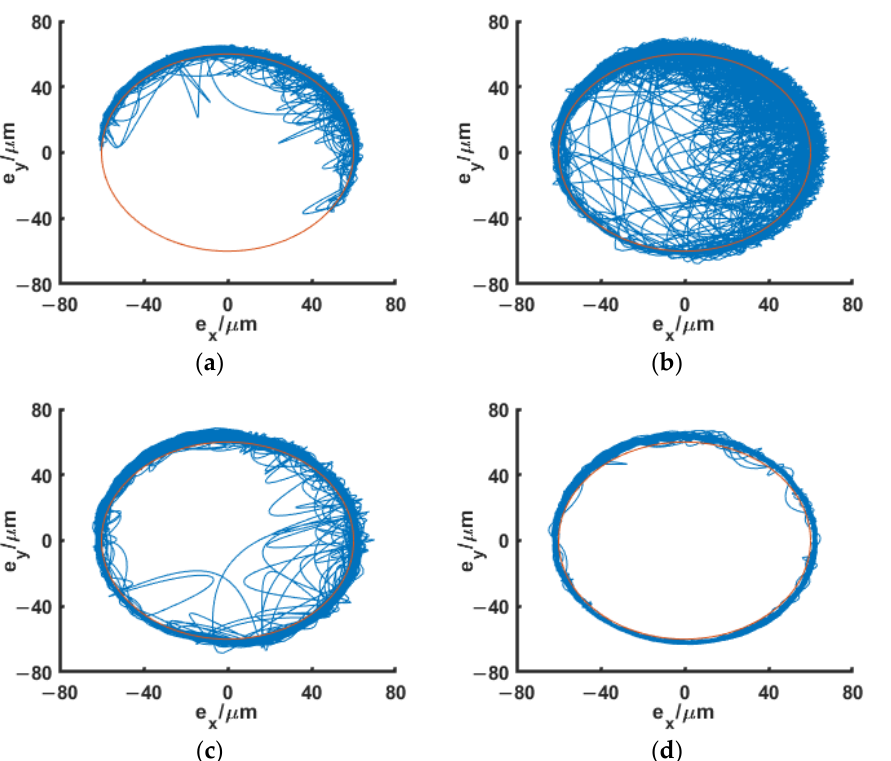
Figure 8. Axis trajectory of shaft at different driving speeds. ( a ) ω = 25. ( b ) ω = 30. ( c ) ω = 35. ( d ) ω = 40.